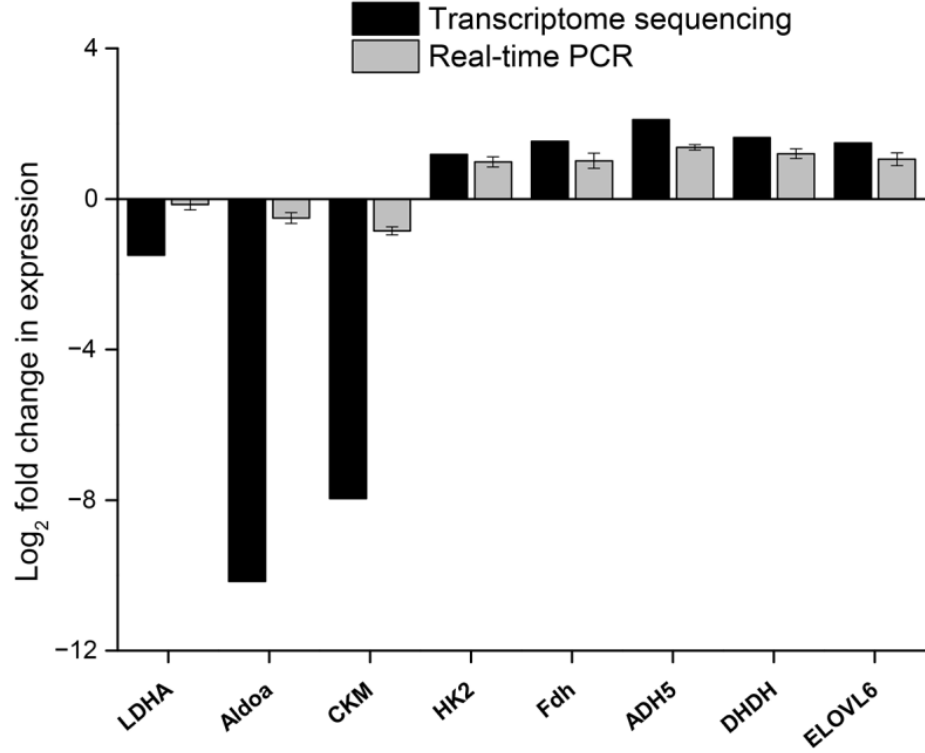
Figure 4. Expression of eight differentially expressed genes from the transcriptome validated by qRT-PCR.